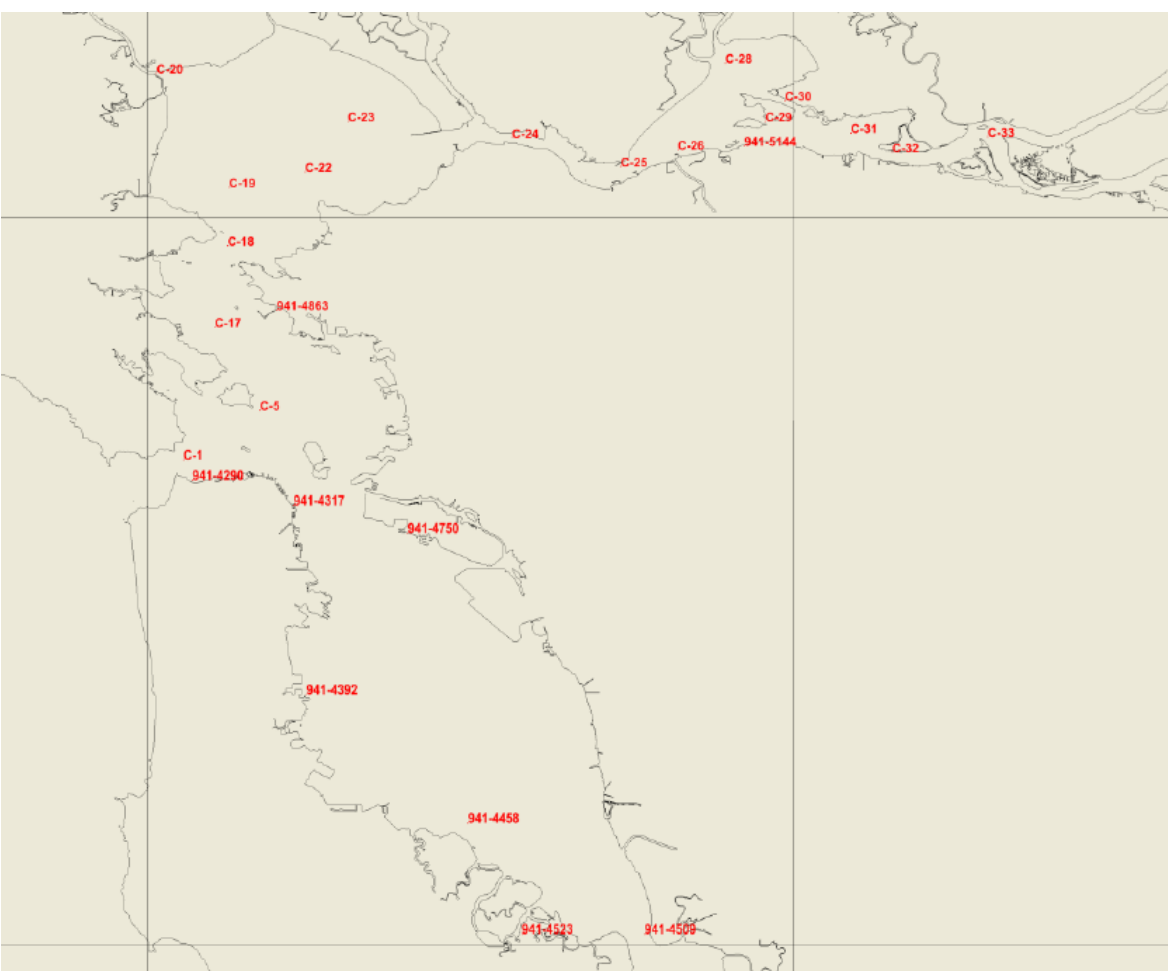
Figure 6. NOS and USGS Historical Circulation Survey Water Level, Current, Salinity, and Temperature Stations. Note current meters were collocated with conductivity-temperature sensors. Note the location of Point Reyes is shown in Figure